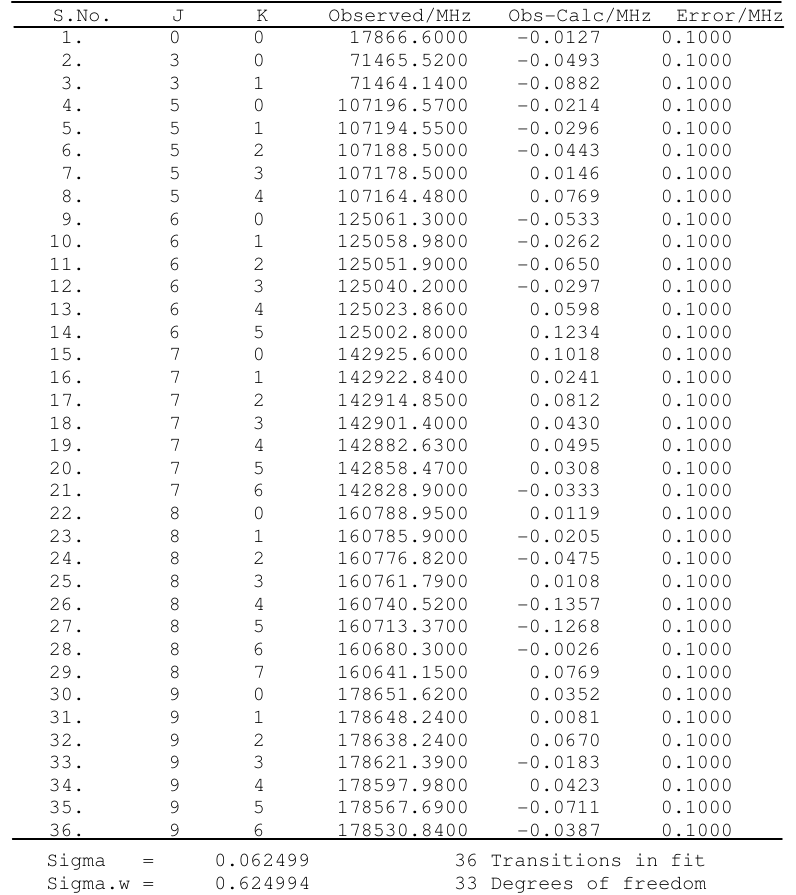
Table 4 . Results of refinement of observed frequencies for 13 CH